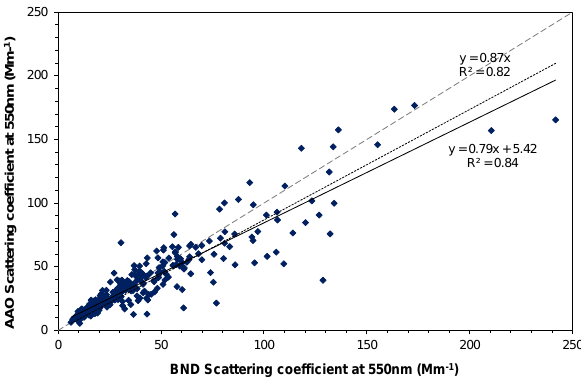
Fig. 13. Frequency distribution of AAO R sp for all flight segments over Bondville (red) and for flight segments where the scattering coefficient was ≥ 5Mm − 1